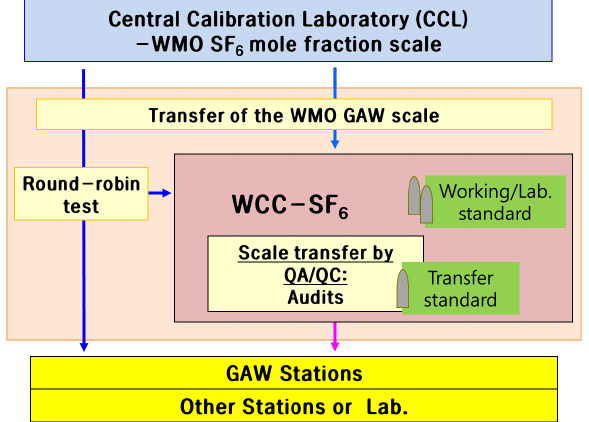
Figure 4 Traceability chain of SF 6 from the CCL and GAW stations. 3 Fig. 4. Traceability chain of SF 6 from the CCL and GAW stations.